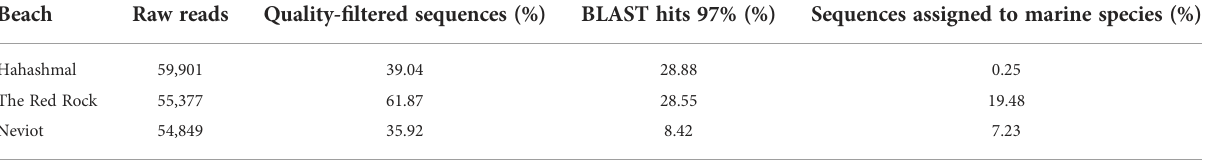
TABLE 2 NGS results in the analyzed samples, as number of raw reads, proportion of quality- fi ltered sequences, proportion of sequences assigned to a taxonomic unit from BLAST using 97% identity threshold, and proportion of sequences assigned to marine species. Beach Raw reads Quality- fi ltered sequences (%) BLAST hits 97% (%)